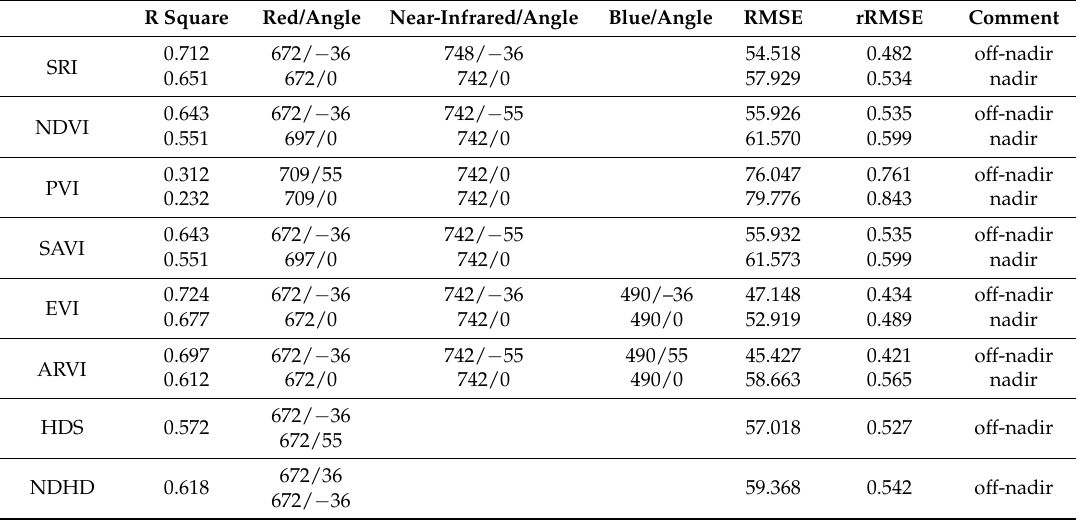
Figure 3. Correlation coefficients between all band reflectances and biomass. Table 6. View-illumination effects for the nadir with the off-nadir angle, using ground measures and CHRIS data.